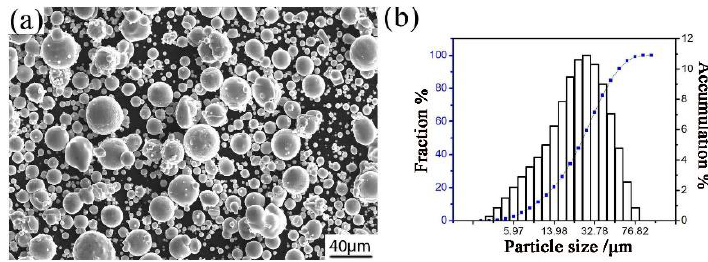
Figure 1. The image ( a ) and particle size distribution ( b ) of the Al–Fe–Cr–Ti alloy powder.